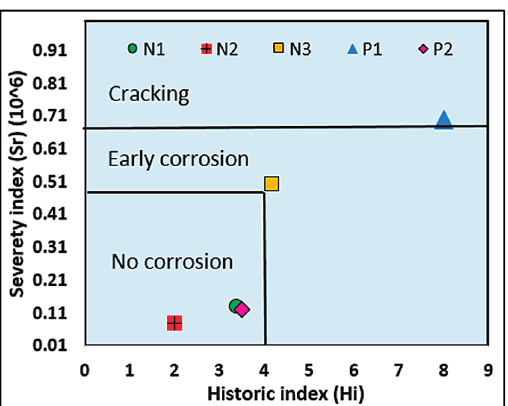
Figure 10. Intensity analysis results (Reproduced and modified from